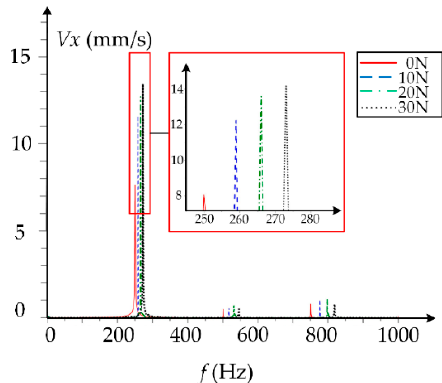
Figure 15. The bearing vibration under different axial loads when L = 1.9.